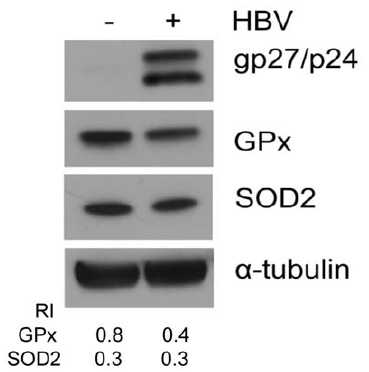
Figure 3. Suppression of GPx by HBV in C3A human hepatoma cells line. C3A cells transiently transfected with pHBV1.3 or empty vector for 48 h were lysed for Western blot analysis for HBV small surface proteins (glycosylated/unglycosylated, gp27/p24), GPx and SOD2. a -tubulin was also analyzed to serve as a loading control. The RIs of GPx and SOD2 to a -tubulin are shown in the lower panel.